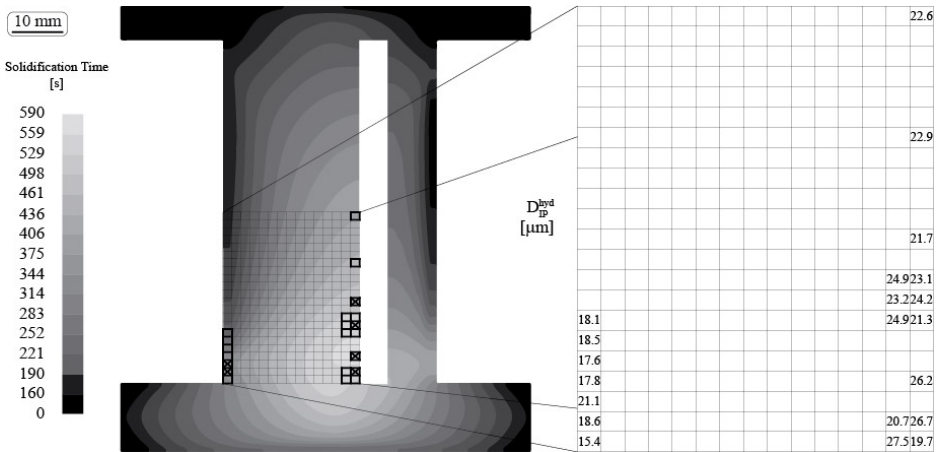
Figure 4. Simulated local solidification time and the measured hydraulic diameter of the intradendritic phase in the right ‐ hand side grid. The gray color scale plotted on the cross section of the SP sample geometry represents the simulated local solidification time.